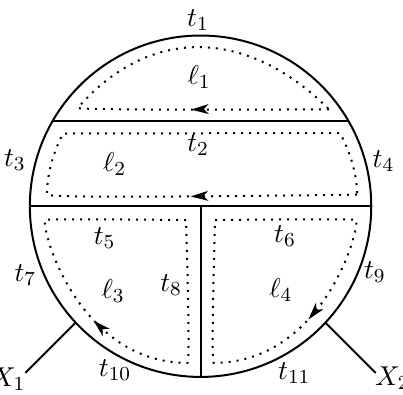
Figure 1. A graph with E = 11 internal edges labelled with Schwinger parameters t i , n = 2 external edges labelled X j and g = 4 loops with a basis f ‘ i g